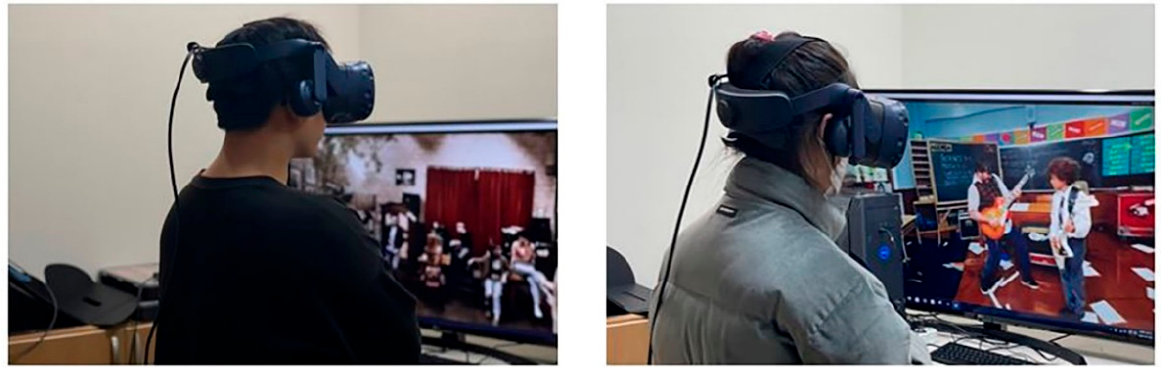
Figure 15. The 360-degree VR eye-tracking experiment.